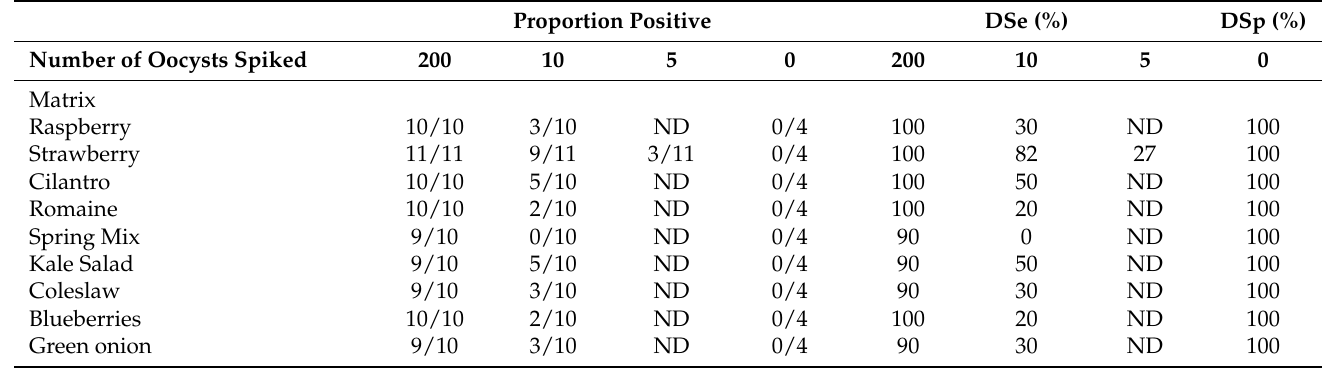
Table 2. Number of positive samples detected by the Cyclospora qPCR for each matrix verified. Proportion Positive DSe